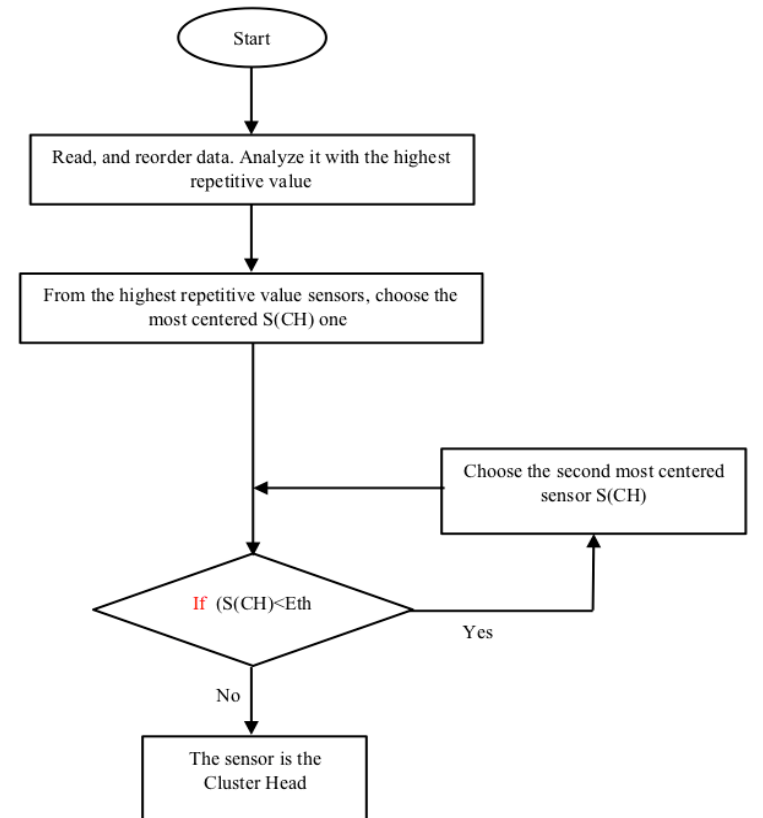
Fig. 6. Cluster Head (C.H.) selection